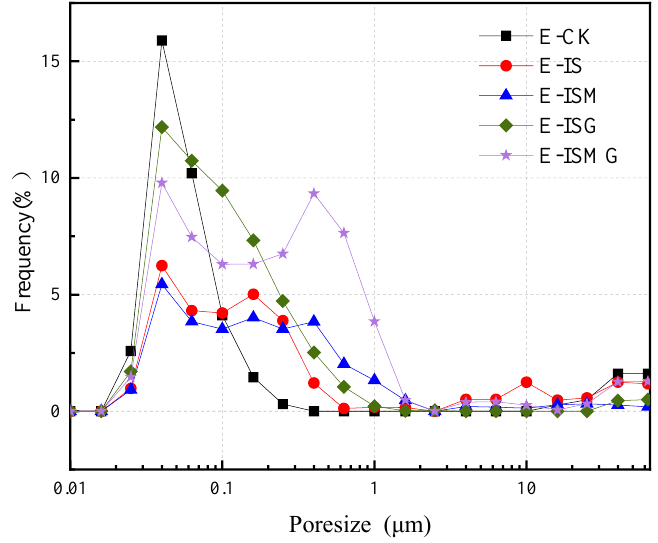
Figure 5. Distribution of pores for EC specimens at 28